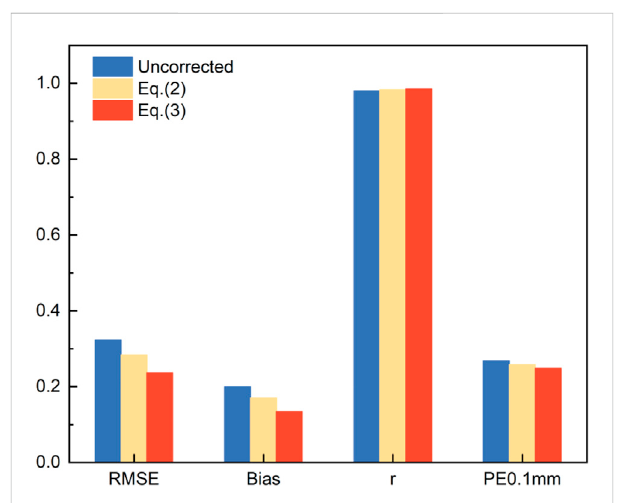
FIGURE 7 RMSE, mean bias, r, and PE 0.1mm of snowfall in S1 Eqs 2, 3 are the results calculated by recalibrated parameters in